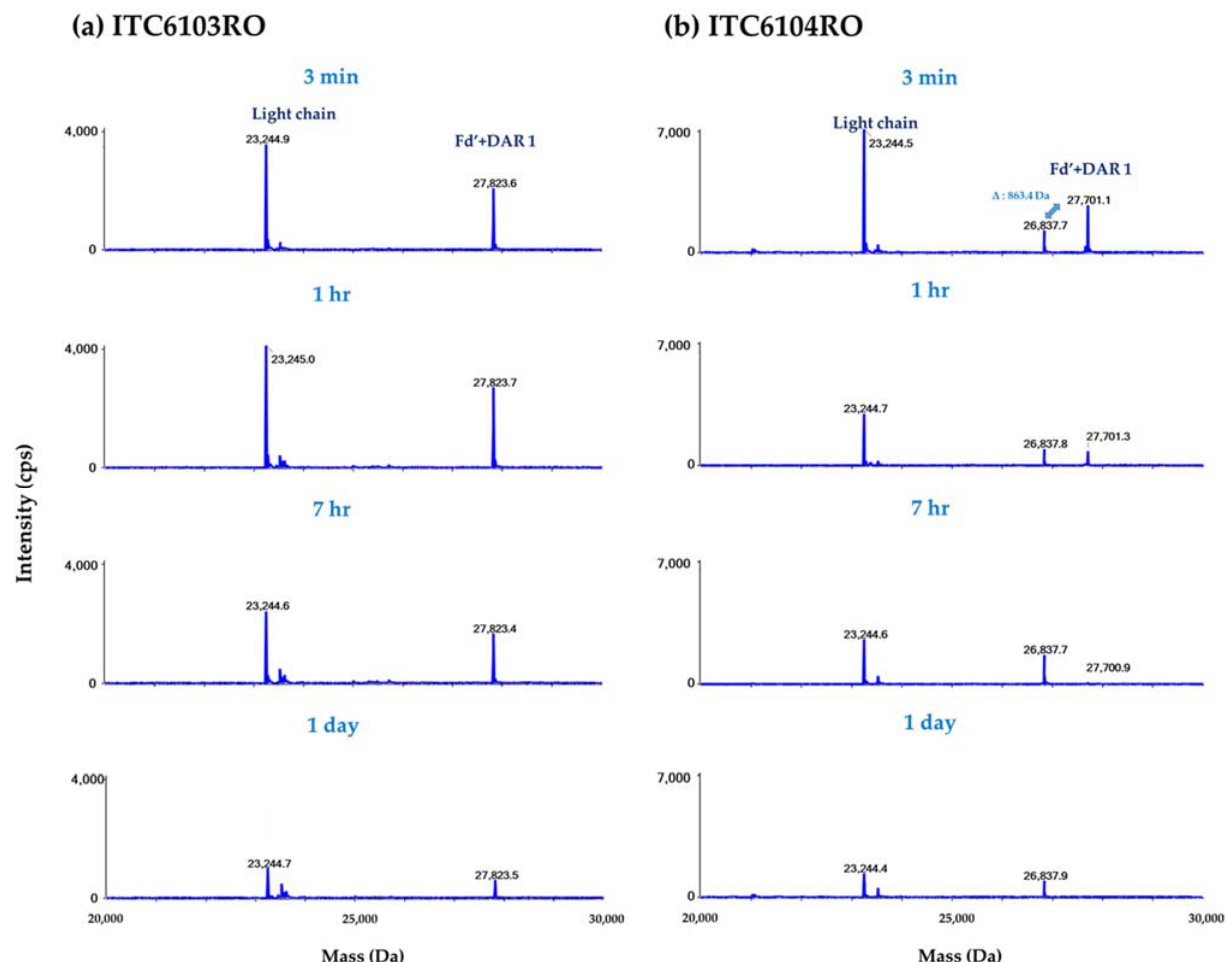
Figure 7. The deconvoluted spectra for ( a ) ITC6103RO and ( b ) ITC6104RO from the in vivo mouse pharmacokinetic samples.